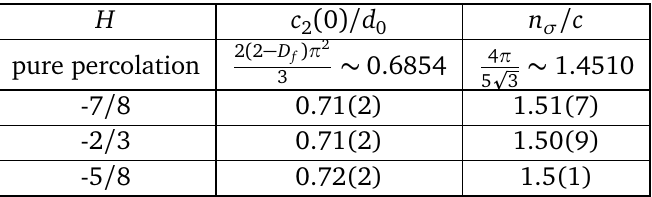
( 0 ) / d and ratio of the spin field multiplicity n σ to the 2 0